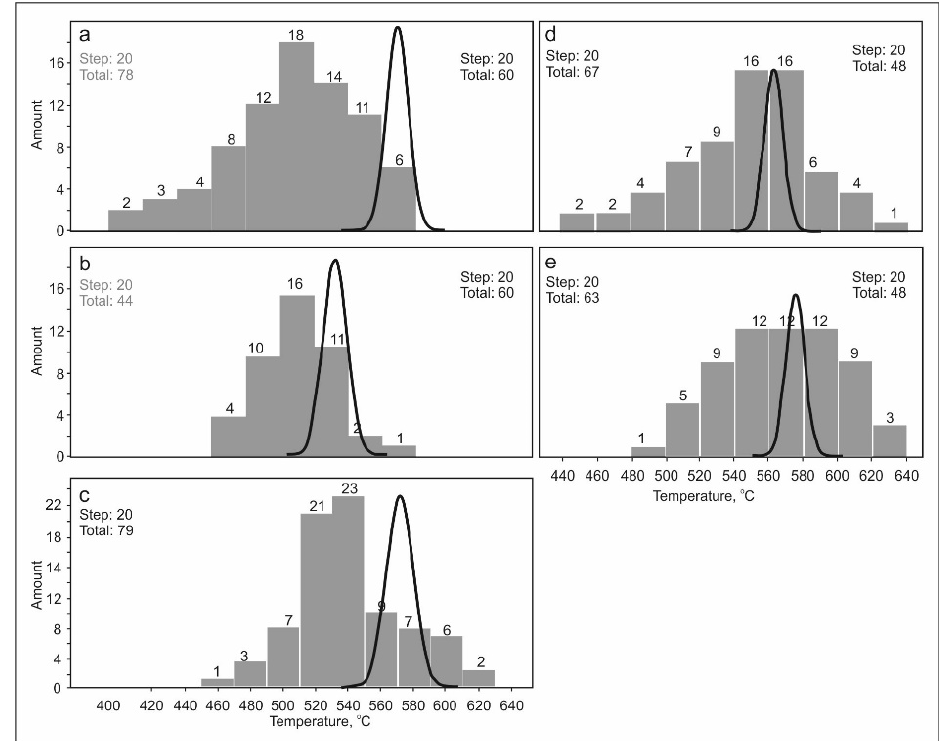
Figure 7. An example Raman spectrum of CM from the sample oc-24 from Olympiada deposit, il- lustrating four distinct peaks.